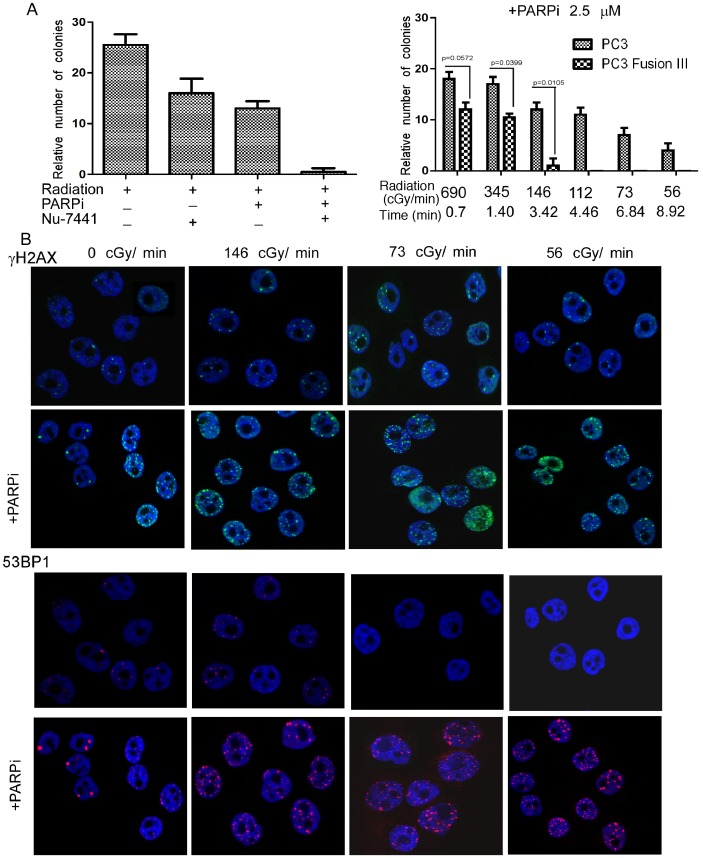
The TMPRSS2-ERG fusion gene provides enhanced sensitivity to PARP inhibition, comparable to that of DNA-PKcs inhibition in parental cells.A, Clonogenic survival assay in PC3 cells following 4 Gy radiation ±2.5 µM rucaparib and the DNA-PKCs inhibitor NU7441 (500 nM; left panel). B, Clonogenic survival assays in PC3 cells and derivatives expressing TMPRSS2-ERG fusion III at different dose-rates ±2.5 µM rucaparib. C, Immunostaining for χH2AX and 53BP1 in PC3 cells expressing the fusion gene following radiation ± rucaparib treatment for 24 h. Error bars represent SD of mean (n = 3).